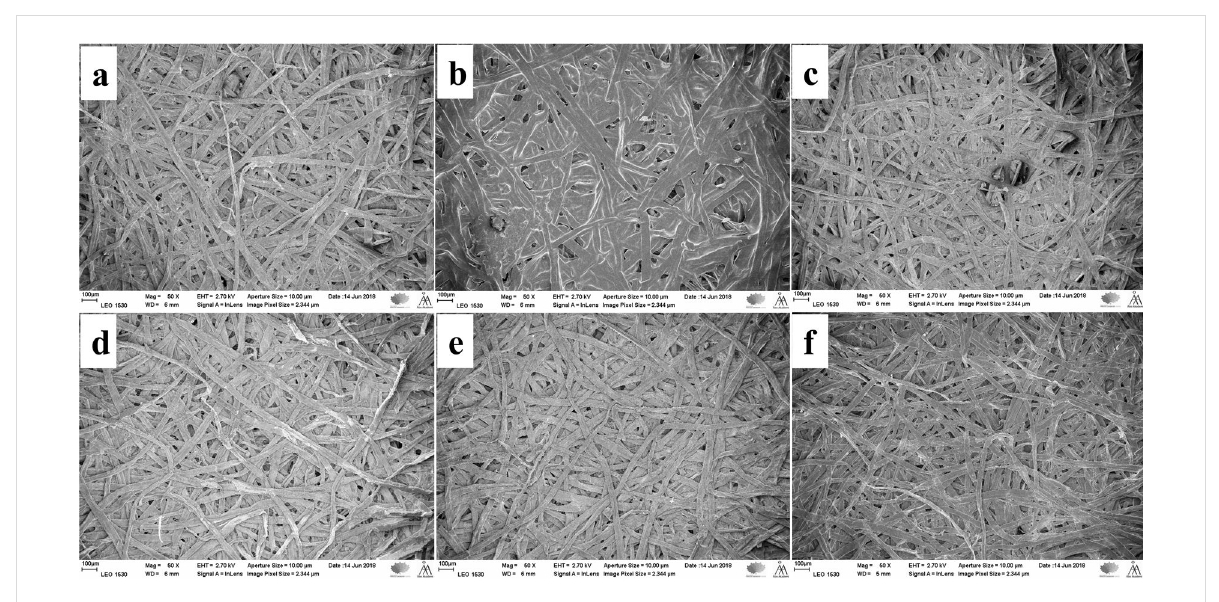
Figure 8: SEM images of the UBKPR fibers: (a) REF (b) C-F (c) HF (d) C-HF (0.15 M) (e) C-HF (0.30 M) (f) C-HF (0.45 M).